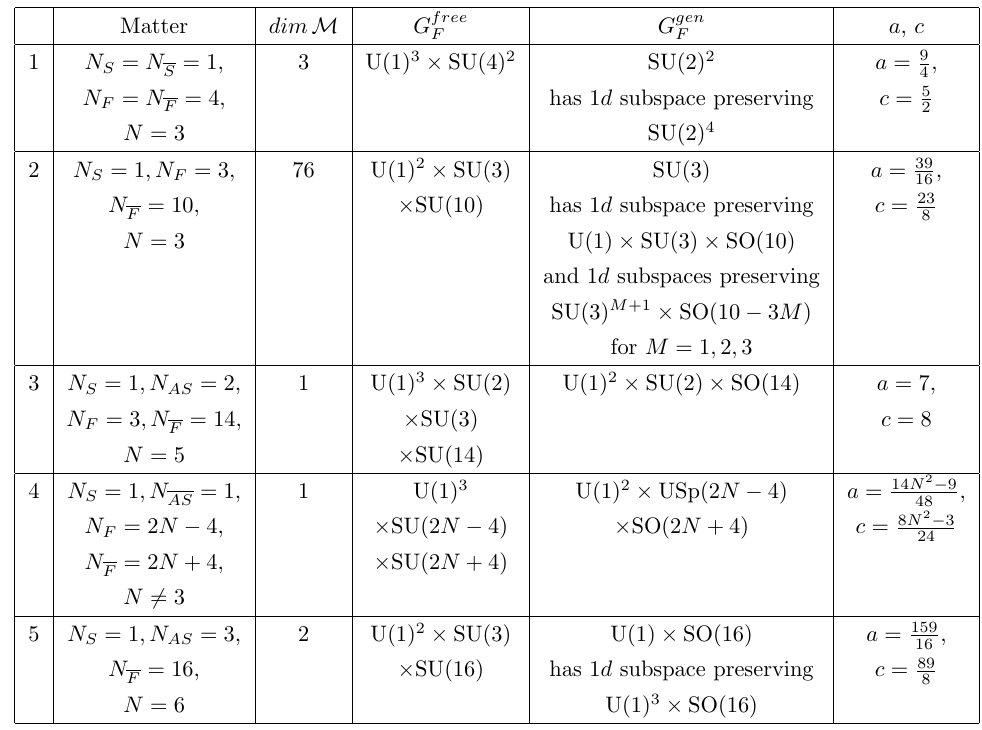
Table 5 . Cases involving an SU( N ) gauge group with symmetric chiral (cid:12)elds, but no adjoint